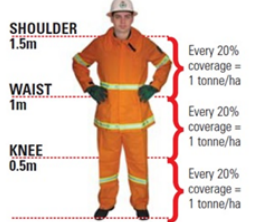
Figure 3: Knee-waist-shoulder estimation guidelines for HR Burning (Forestry Commission of Tasmania, 1984).